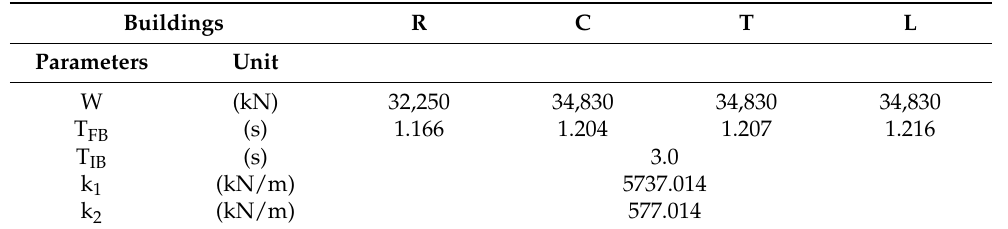
Table 2. Properties of isolated-base and fixed-base